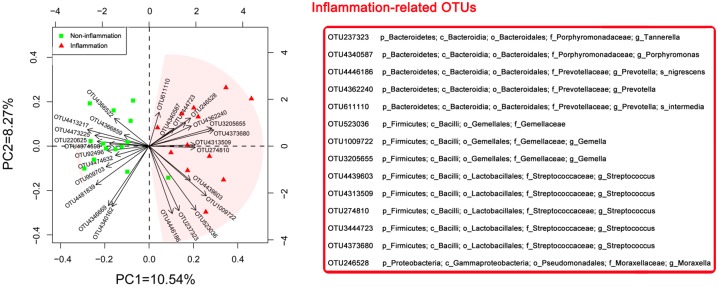
Principal component analysis (PCA) of the pre-operative OTUs information for the post-operative inflammation and non-inflammation groups.Based on 26 different OTUs of the pre-operation (relative abundance higher than 0.01%) between the two groups, the inflammation samples appeared to cluster together in the direction opposite to that of the non-inflammation samples. The 14 OTUs with the pink shadow on the right of the diagram were closely related to post-operative inflammation at the grafted sites.